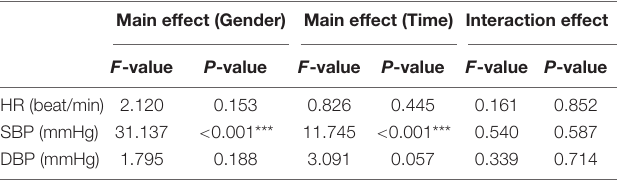
TABLE 2 | Results of 2 × 3 factorial analysis design on gender and time for HR, SBP, DBP during Baseline, Post-task 1 and Post-task 2. Main effect (Gender) Main effect (Time) Interaction